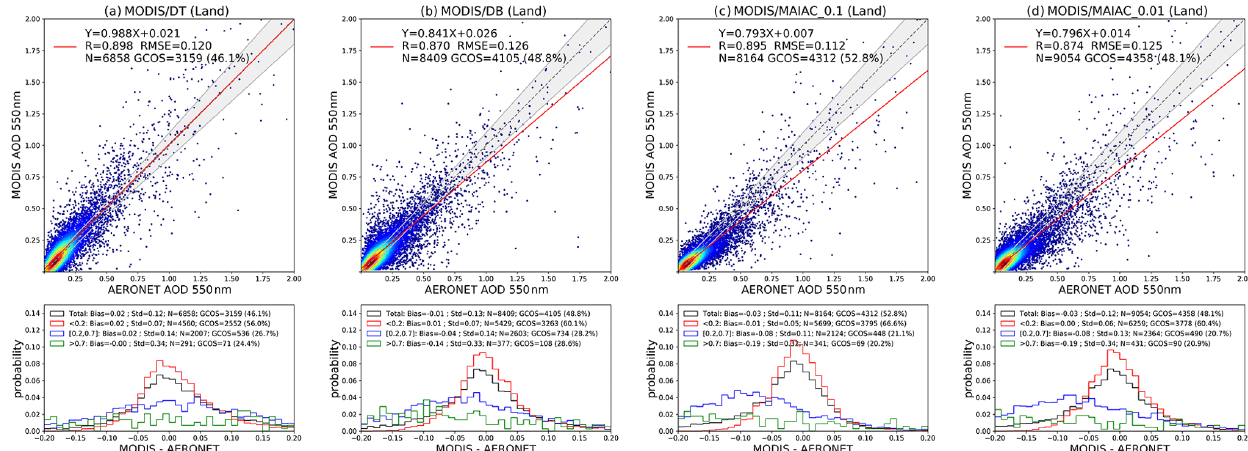
Figure 8. Validation of MODIS AOD at 550nm over land in 2008: (a) DT, (b) DB, (c) MAIAC_0.1, (d) MAIAC_0.01. The gray dashed line and the red solid line are the 1 : 1 reference line and the linear regression line. The gray envelope indicates GCOS requirement: max (0.04 or 0.1AOD). The probability density functions of differences (MODIS–AERONET) are present in the lower panels. The black, red, blue and green solid lines indicate all AOD conditions: any AOD, AOD < 0.2, 0.2 ≤ AOD ≤ 0.7 and AOD > 0.7, respectively.